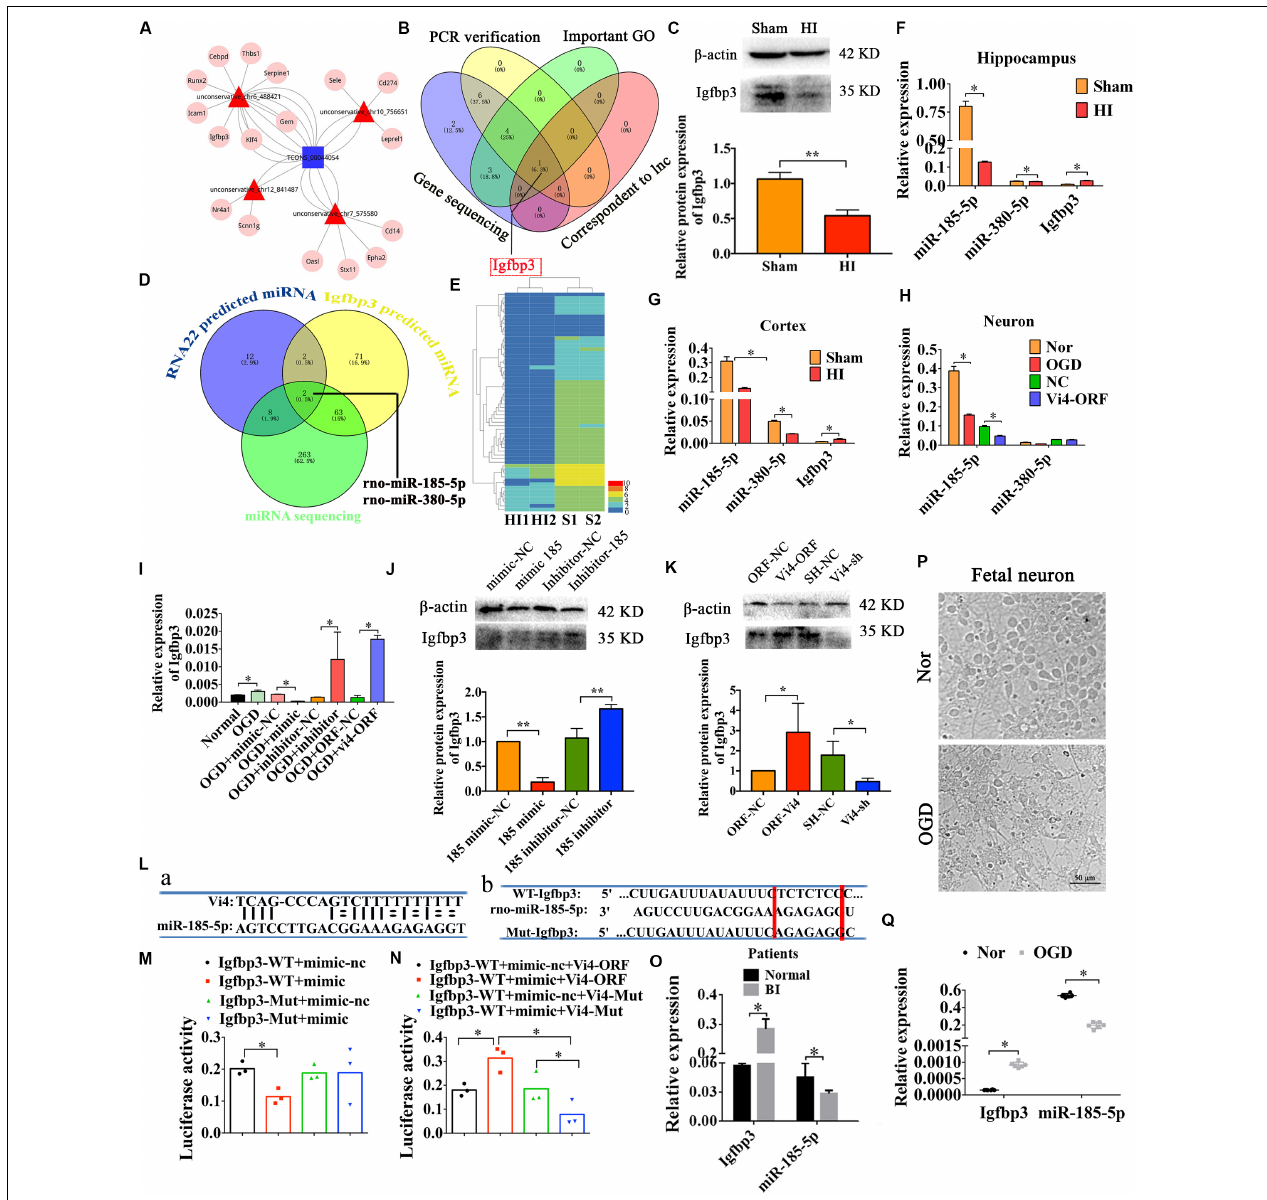
FIGURE 4 | Regulatory relationships among Vi4, miR-185-5p and Igfbp3 in sites and expression. (A) ceRNA analysis of Vi4 among diverse miRNAs and mRNAs. The blue square represents Vi4, the red triangles represent miRNAs, and the pink circles represent related genes. (B) Intersection of PCR verification, important GO analysis, gene sequencing and correspondent to lnc via bioinformatics analysis for selecting the target gene to Vi4 in the venny 2.1 software. (C) Western blot detection of the cortical brain tissues in the sham and HI rats, n = 6/group. (D) Intersection of RNA22 prediction, TargetScan for Igfbp3-predicted miRNAs and miRNA sequencing to further find the miRNAs that is the most relevant to Igfbp3 and Vi4. (E) The heat map of miRNA sequencing between Sham (S1, S2) and HI (H1, H2) groups at 24 h after HI, n = 2 in each group. miR-185-5p and miR-380-5p were finally obtained. Red indicates high expression, and blue low expression. (F) Relative expression of miR-380-5p, miR-185-5p and Igfbp3 in the sham and HI groups in hippocampus 24 h post HI, n = 8/group. (G) Relative expression miR-380-5p, miR-185-5p and Igfbp3 in cortex 24 h after HI, n = 8/group. (H) Relative expression of miR-380-5p and miR-185-5p in neurons 24 h after OGD, n = 6/group. (I) Relative expression of Igfbp3 in neurons 24 h after OGD, n = 6/group. (J,K) Western blot detection of the expression of Igfbp3 protein in the cortical neurons in 24 h after OGD, n = 6/group. (L,a) The binding sites between Vi4 and miR-185-5p predicated by RNA22 software. (L,b) The binding sites between miR-185-5p and Igfbp3 3 (cid:48) UTR predicted by TargetScan. The Mut sequences designed for Igfbp3 3 (cid:48) UTR in luciferase reporter assay. (M,N) Relative luciferase activities in each group at 48 h after transfection, n = 6/group. (O) Relative expression of Igfbp3, and miR-185-5p in the serum of BI patients and normal controls. n = 23/group. (P) The primary cortical neurons from the aborted fetus in the normal and OGD condition. Scale bar = 50 µ m. (Q) Quantitative detection of the expressional level of miR-185-5p and Igfbp3 in the human neurons after OGD insults, n = 6/group. For (C,F–I,O,Q) , the relative expression was relative to that of the sham or normal group. For (J) , the relative expression was relative to that of the 185-mimic-nc group. For (K) , the relative expression was relative to that of the ORF-NC group. WT, wild type; BI, brain ischemia; Mut, mutant. Data are shown as mean ± SD, * P < 0.05.